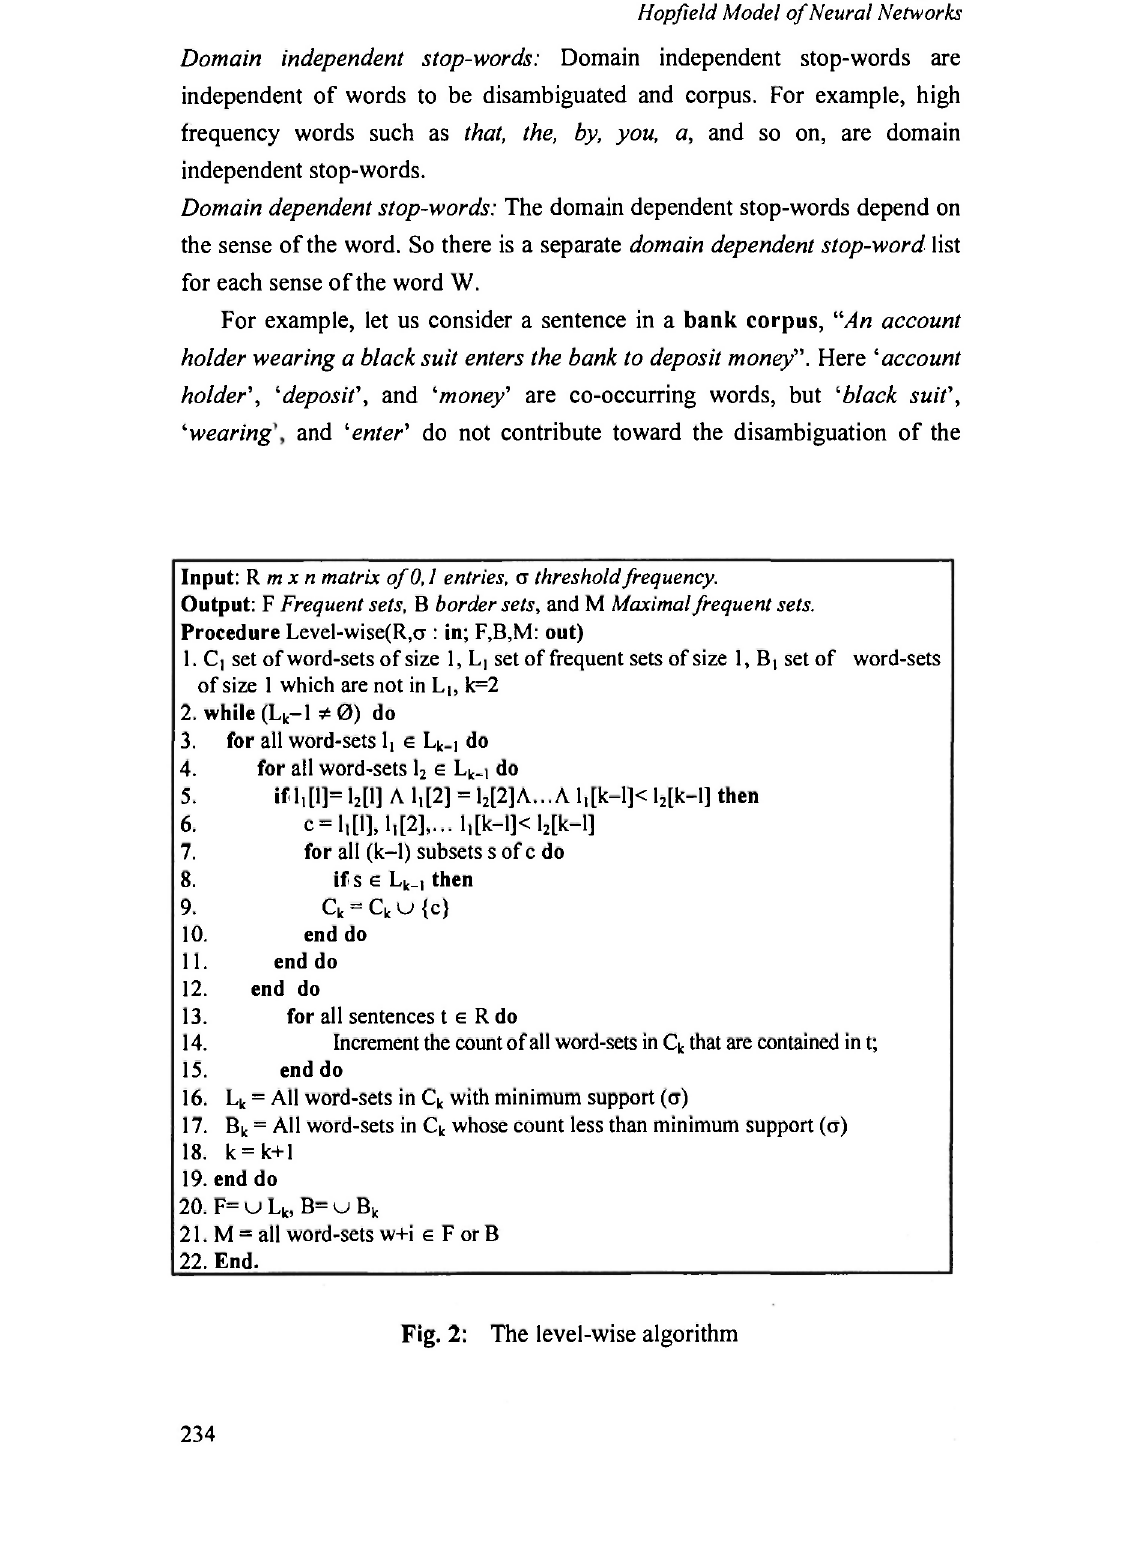
Fig. 2: The level-wise